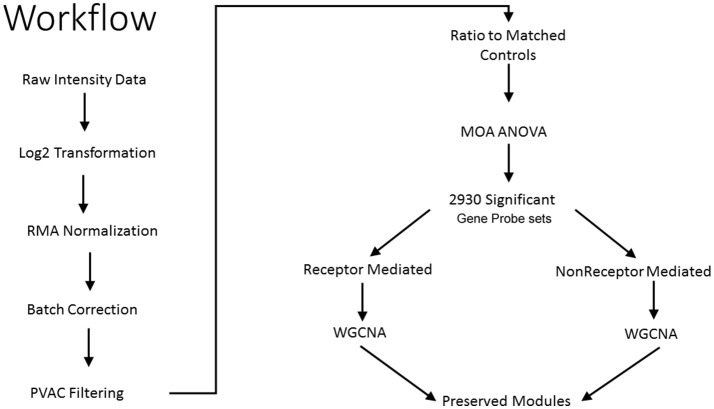
Workflow to identify preserved gene co-expression network modules. Illustrated is the analytical workflow to preprocess the microarray gene expression data, detect significant gene probe sets, and identify preserved gene network modules between the receptor-mediated (RM) samples and the non-receptor-mediated (NRM) samples. MOA is mode of action, ANOVA is analysis of variance and WGCNA is weighted gene correlation network analysis.